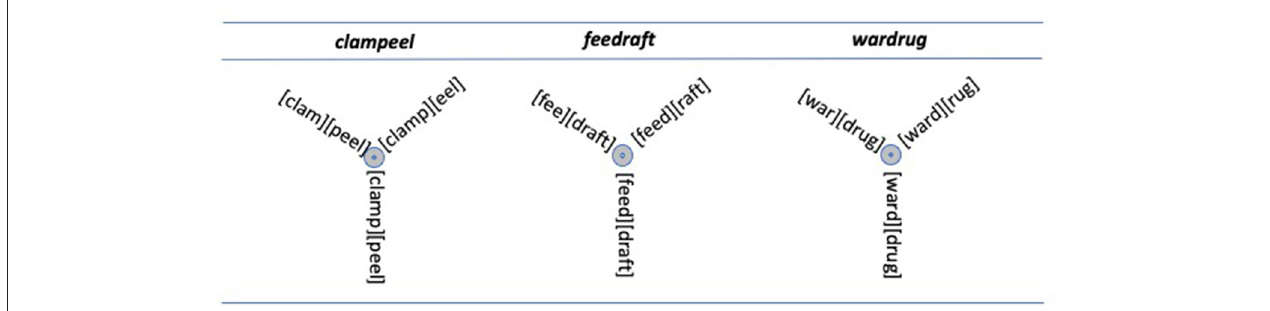
FIGURE 4 | Ambiguous novel compounds. In each case, there are four possible lexical activations. The representations at the bottom indicate that participants are not constrained to produce well-formed parses but, rather, can create an interpretation from, for example, both clamp and peel (even though there is only one letter “p” in the input